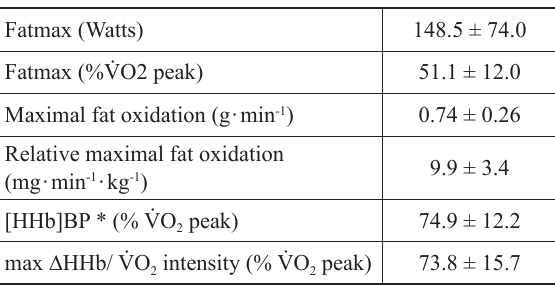
Table 2. Fat oxidation and muscle oxygenation values